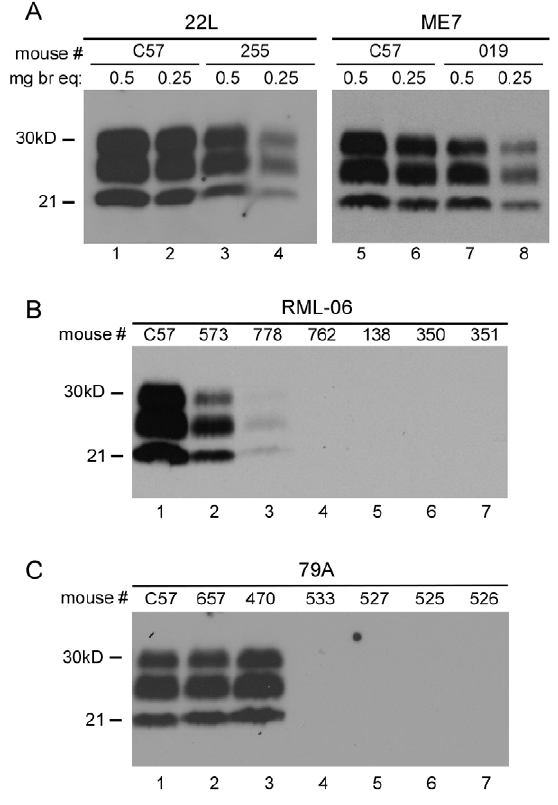
Figure 2. Immunoblot analysis of PrPres in scrapie-infected mice. (A) Panel A shows immunoblots of brain homogenates tested using both 0.5mg and 0.25mg brain equivalents per lane. PrPres levels in clinical Tg330 mice ( # 255 and # 019) were slightly lower than levels seen in clinical C57BL/10 mice. All C57BL/10 and Tg330 mice inoculated with 22L and ME7 scrapie were positive for PrPres by western blot at